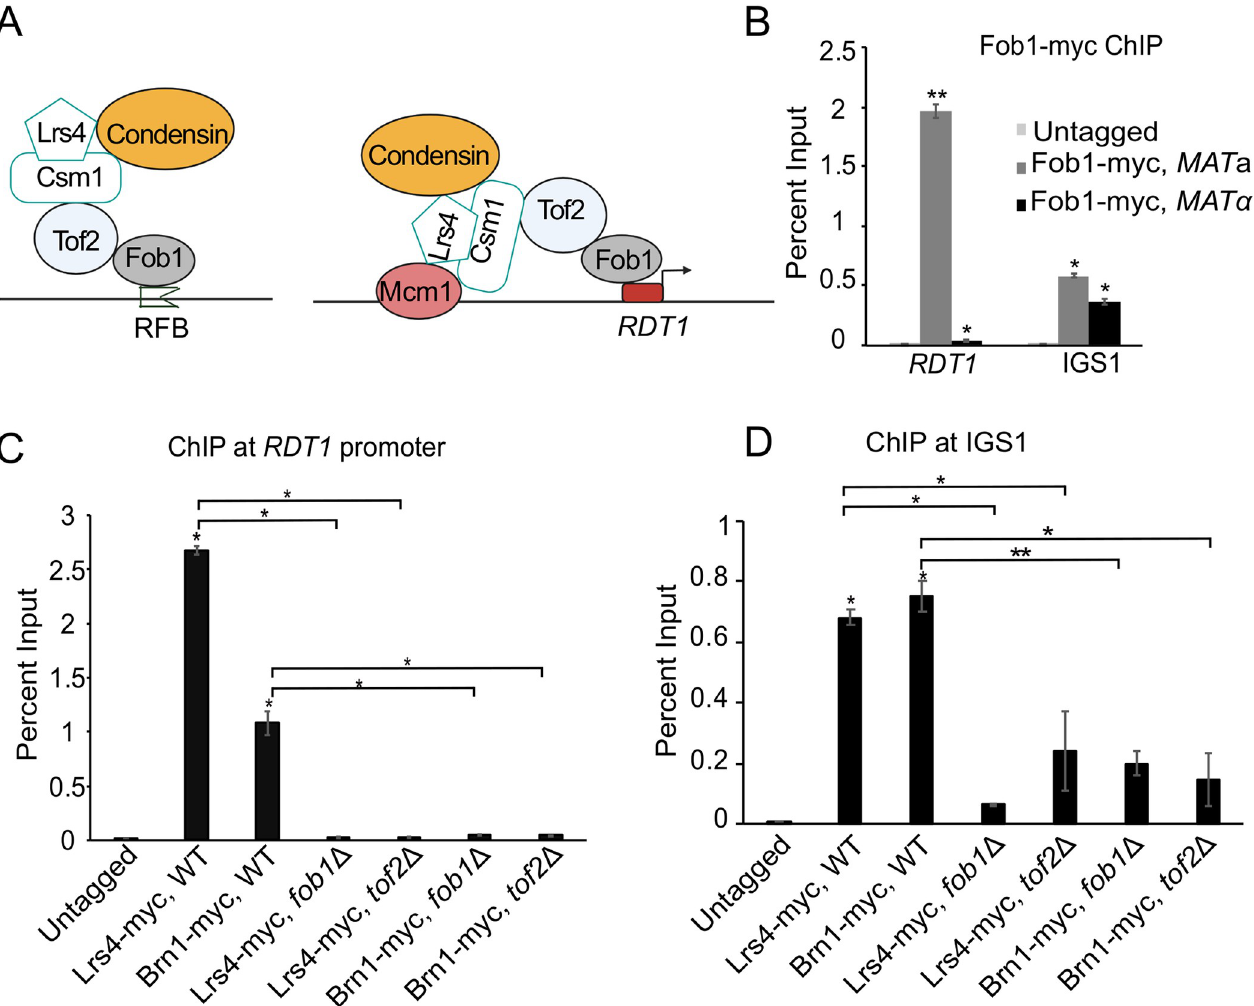
Fig 3. Fob1 recruits cohibin and condensin to the RDT1 promoter. ( A ) Hierarchical models of condensin recruitment to the rDNA and RDT1 promoter. ( B ) ChIP of Fob1-myc at the RDT1 promoter and IGS1 in MAT a and MAT α cells. ( C-D ) ChIP analysis of Lrs4-myc and Brn1-myc enrichment at the RDT1 promoter or IGS1 showing dependence on FOB1 and TOF2 . N = 3 biological replicates for each ChIP experiment; * p < 0.05, ** p < 0.005 using two-sided t-test assuming unequal